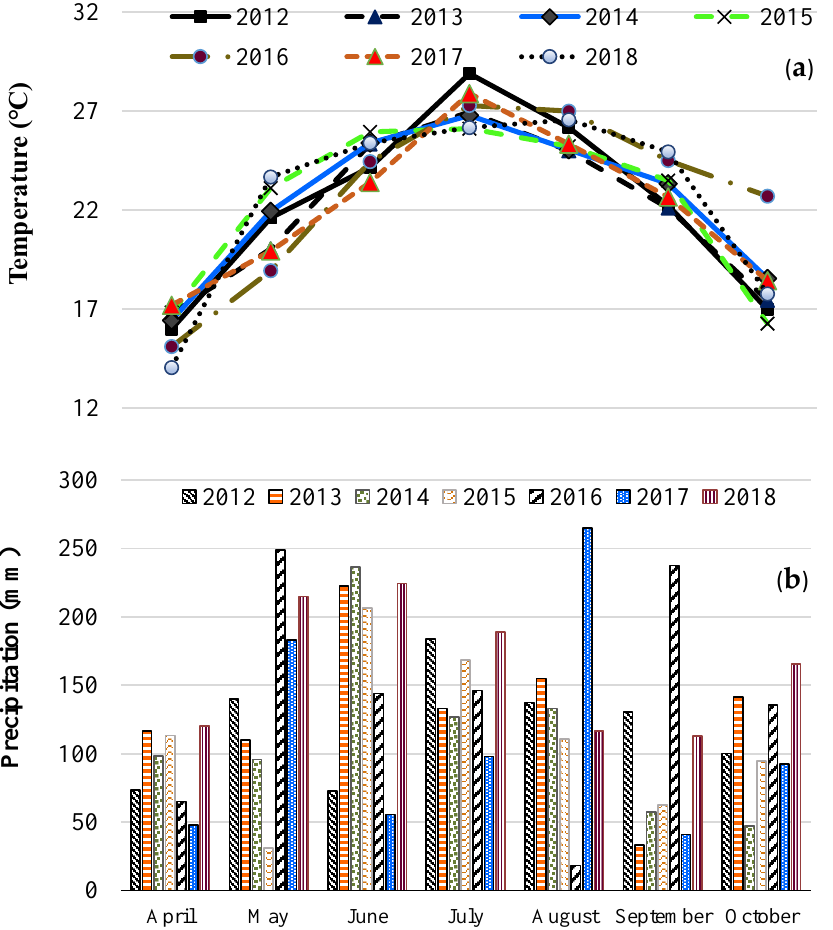
Figure 1. Mean monthly temperatures ( a ), top, and precipitation ( b ), below, recorded at nearby National Weather Service Stations (Hopewell and Petersburg, VA, USA) from April through October during the 2012–2018 production